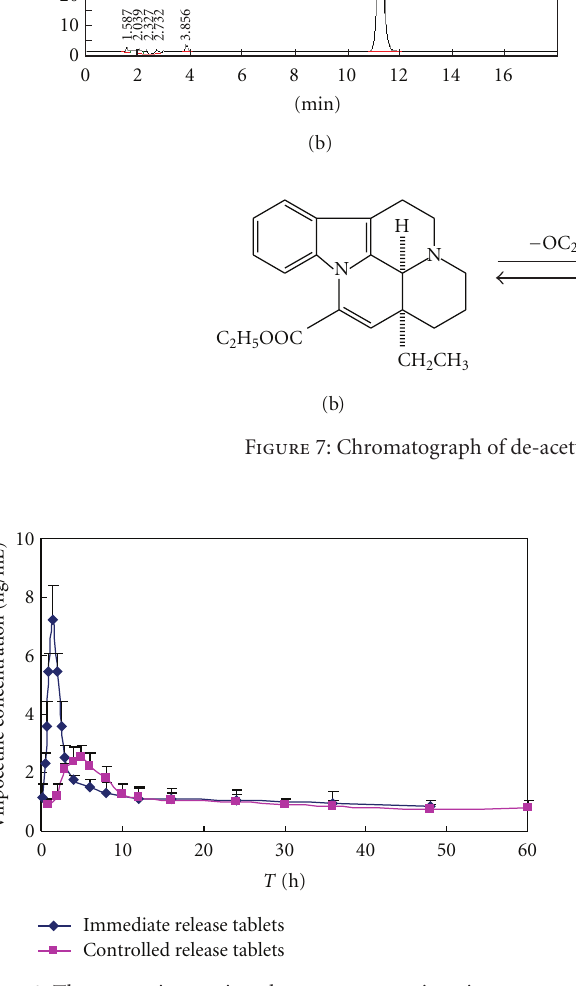
Figure 8: The mean vinpocetine plasma concentration-time curves of vinpocetine osmotic pump controlled-release tablets and imme- diate release tablets after oral administration in dogs ( n = 6).